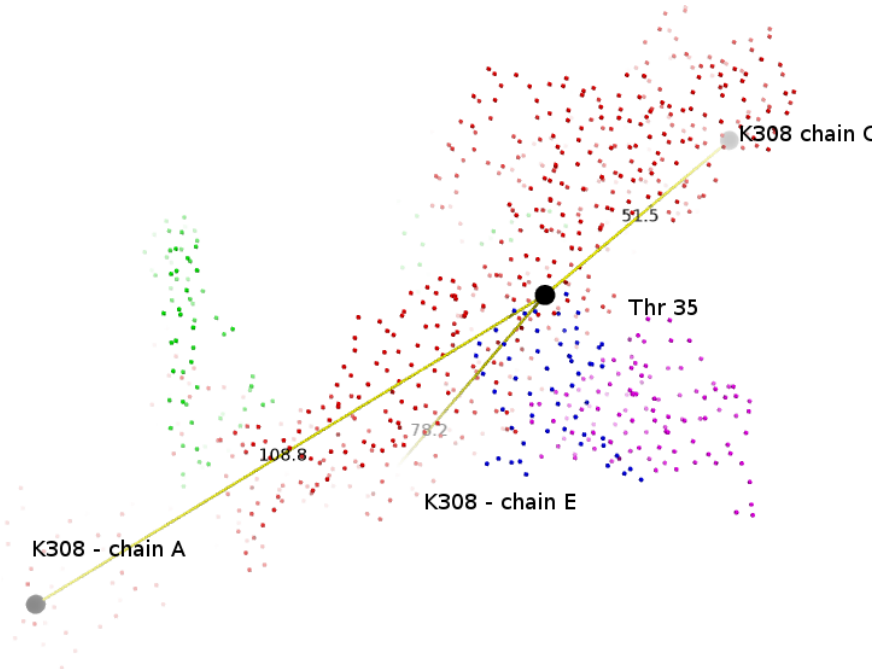
Supplementary Figure 2. Conflicting data on interacting residues of HMAb 5J7 and E-proteins (PDB ID:3J6U). Side-chain densities were not resolved for cryo-EM Fab 5J7–DENV3 map since it had a 9 Å resolution. It is reported that ‘a slightly negatively charged patch formed by T35, S37, S82 and S84 of the heavy chain interacted with a positively charged patch formed by K307 and K308 of the E protein’, by considering interacting residues between Fab and E proteins where pairs of C α atoms are < 8 Å. However, the C α atoms of these residues are quite far. For example, T35 from 5J7 is 108, 51 and 78 Å away from K308 in the three E-proteins (PDB ID:3J6UA, 3J6UC and 3J6UE),